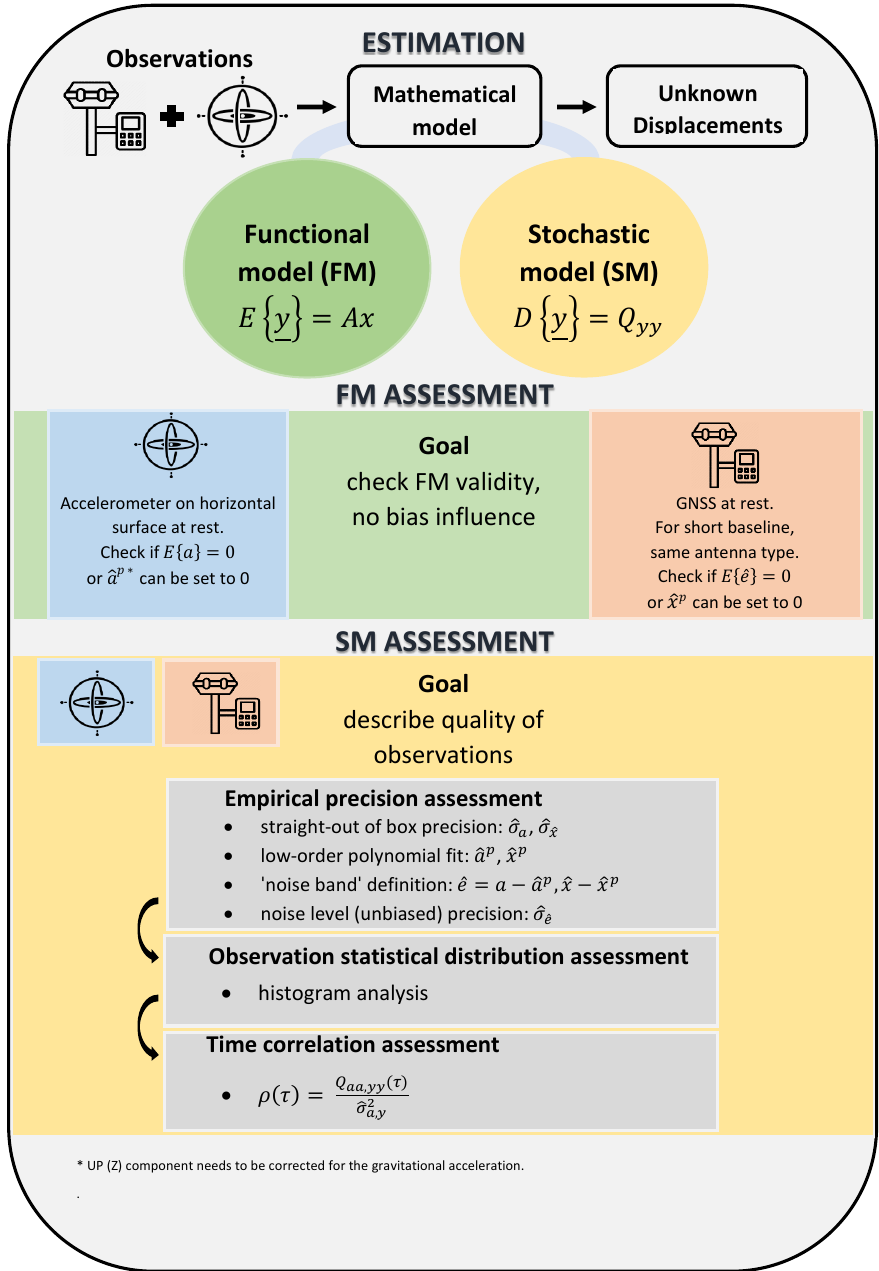
Figure 3. Methodology for mathematical model assessment: For both sensors, the procedure for (green) functional and (yellow) stochastic model assessment is illustrated. For explanation of the mathematical notations, please refer to the abbreviations panel at the end of this